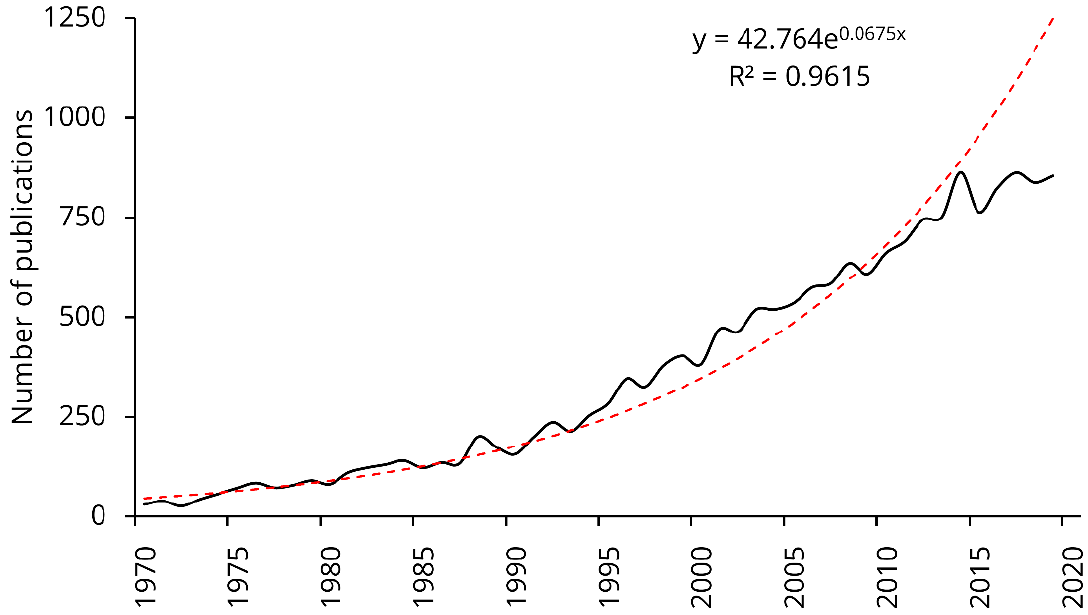
Figure 1. Trend in the number of publications from 1970 to 2019.